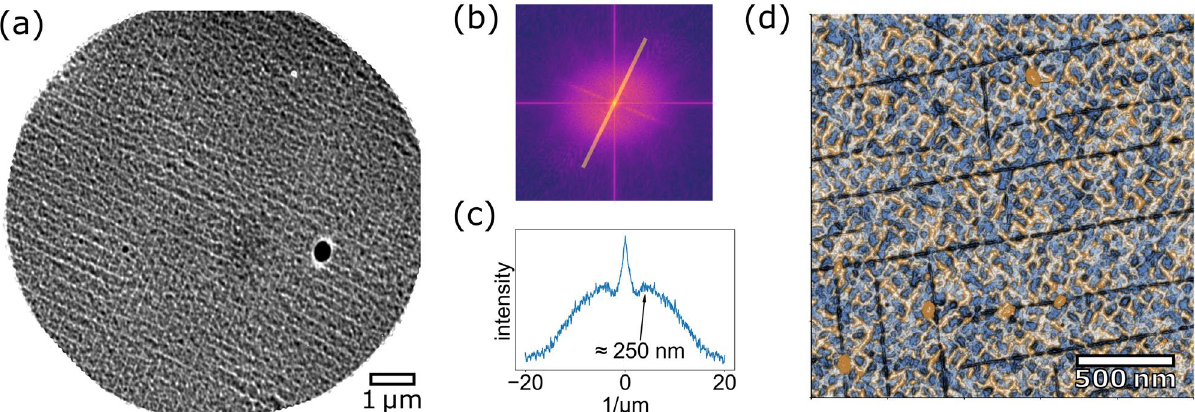
Figure 4. Cracks formed by strain release under thermal cycling. LEEM/MEM image recorded 1.5eV ( a ). The fast Fourier transform exhibits corresponding streaks of intensity ( b ), the maxima in the highlighted profile 250 nm ( c ). The AFM image ( d ) confirms these lines as topographic indicate a quasi-periodic spacing of ≈ cracks and depicts the ripple texture of the stepped (001) surface state as substructure with smaller lateral